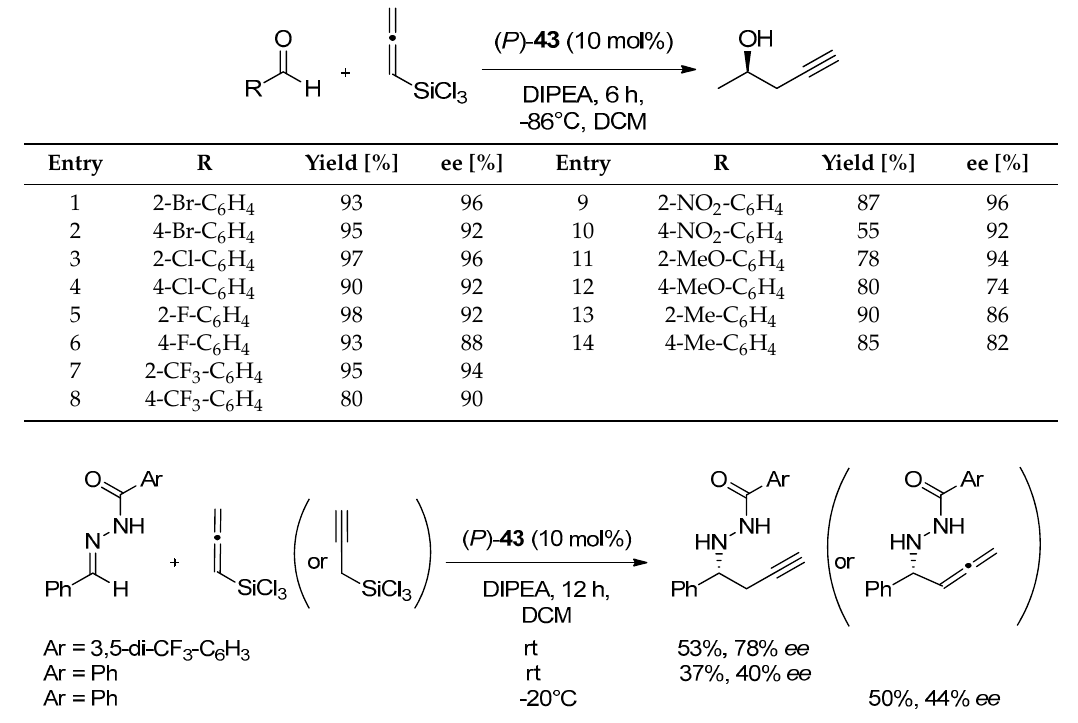
Table 8. Asymmetric propargylation of aldehydes catalyzed by ( P )- 43 [23].